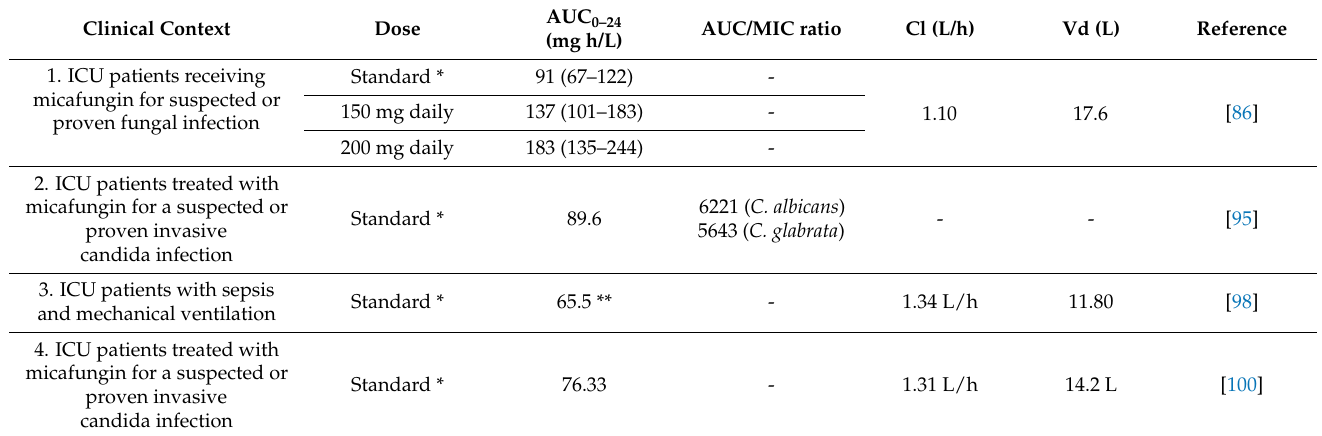
Table 6. Summary of Clinical Studies Assessing PK Parameters of Micafungin in Critically Ill